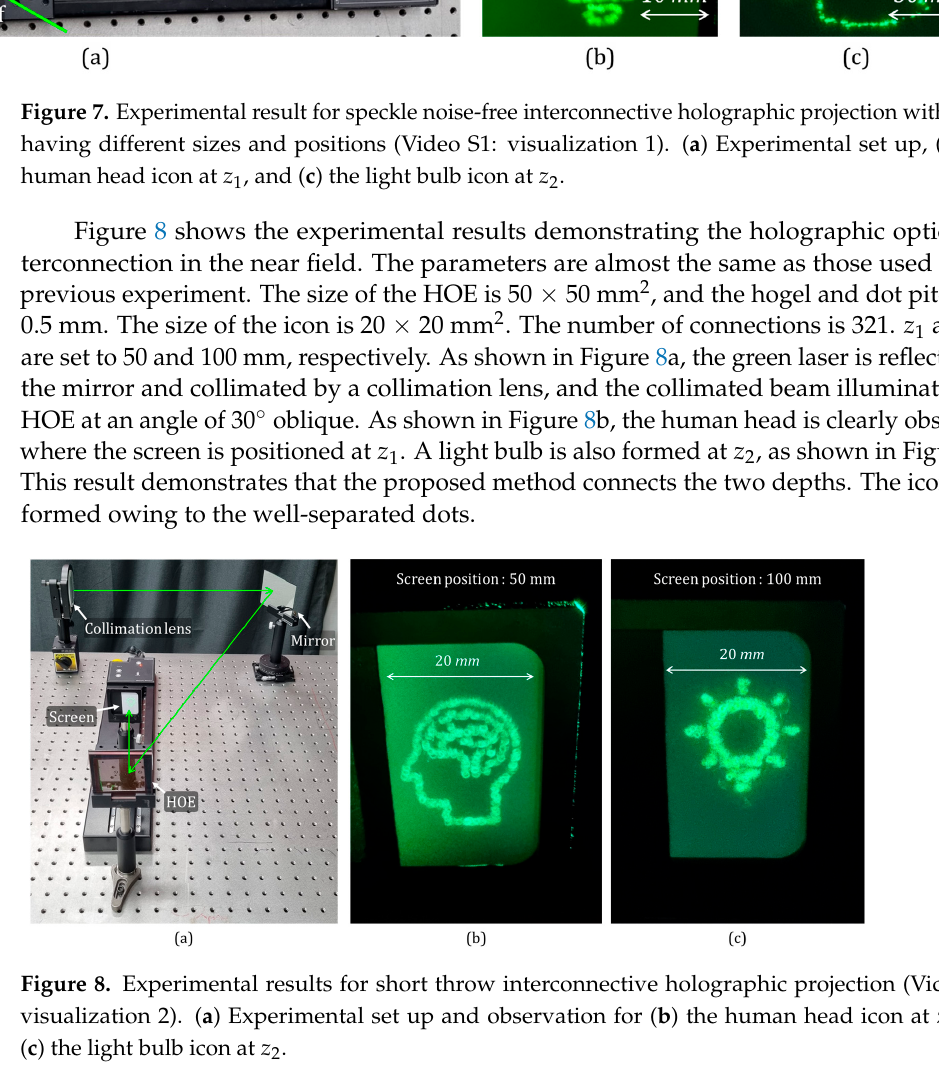
Figure 7. Experimental result for speckle noise ‐ free interconnective holographic projection with icons having different sizes and positions (Video S1: visualization 1). ( a ) Experimental set up, ( b ) the human head icon at z 1 , and ( c ) the light bulb icon at z 2 .